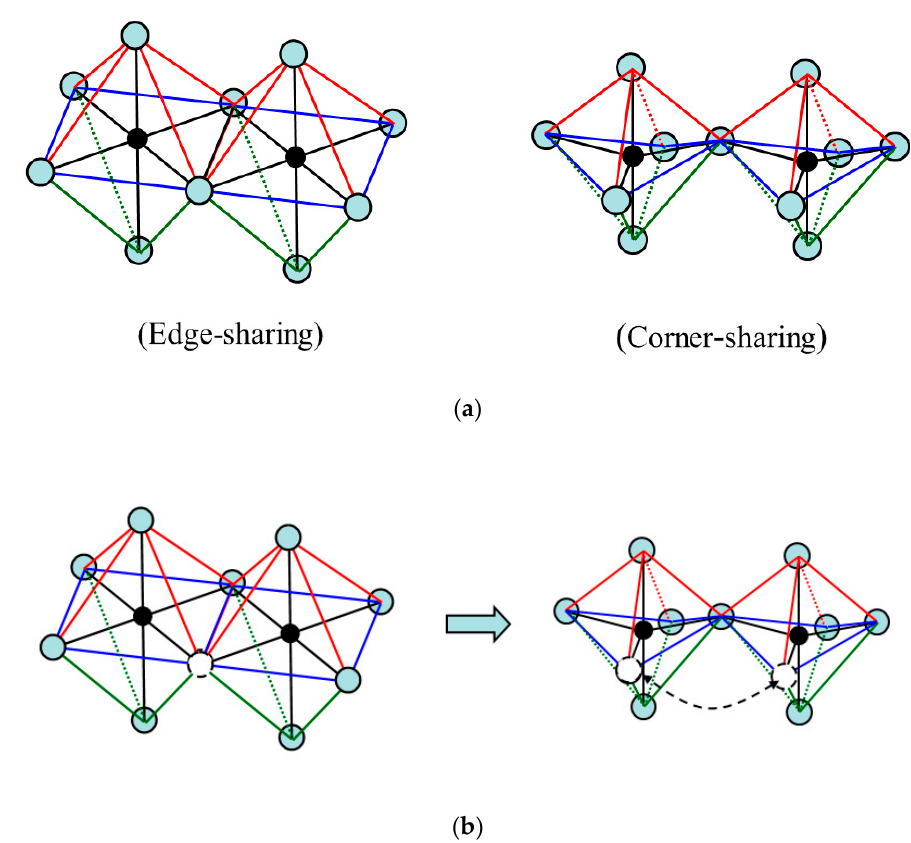
Figure 3. ( a ) Schematics of edge-sharing and corner-sharing of two TiO 6 octahedra. ( b ) The transformation of TiO 6 octahedra from corner-sharing to edge-sharing when one oxygen atom along the shared edge is missing.